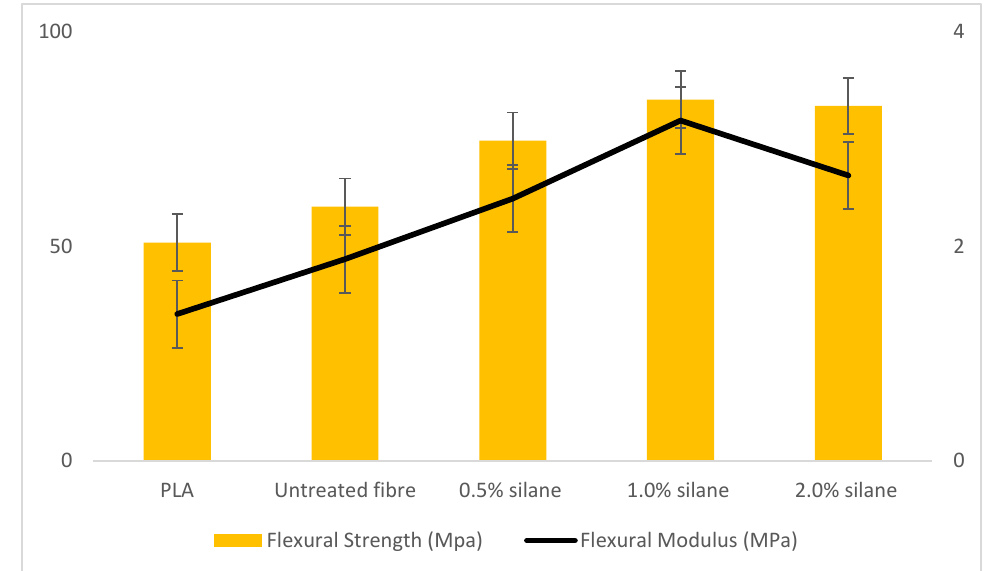
Figure 6. Results of composite flexural strength (MPa) and flexural modulus (MPa). Regarding the flexural modulus, 1.0% silane indicated a high modulus (3174.76 Pa)